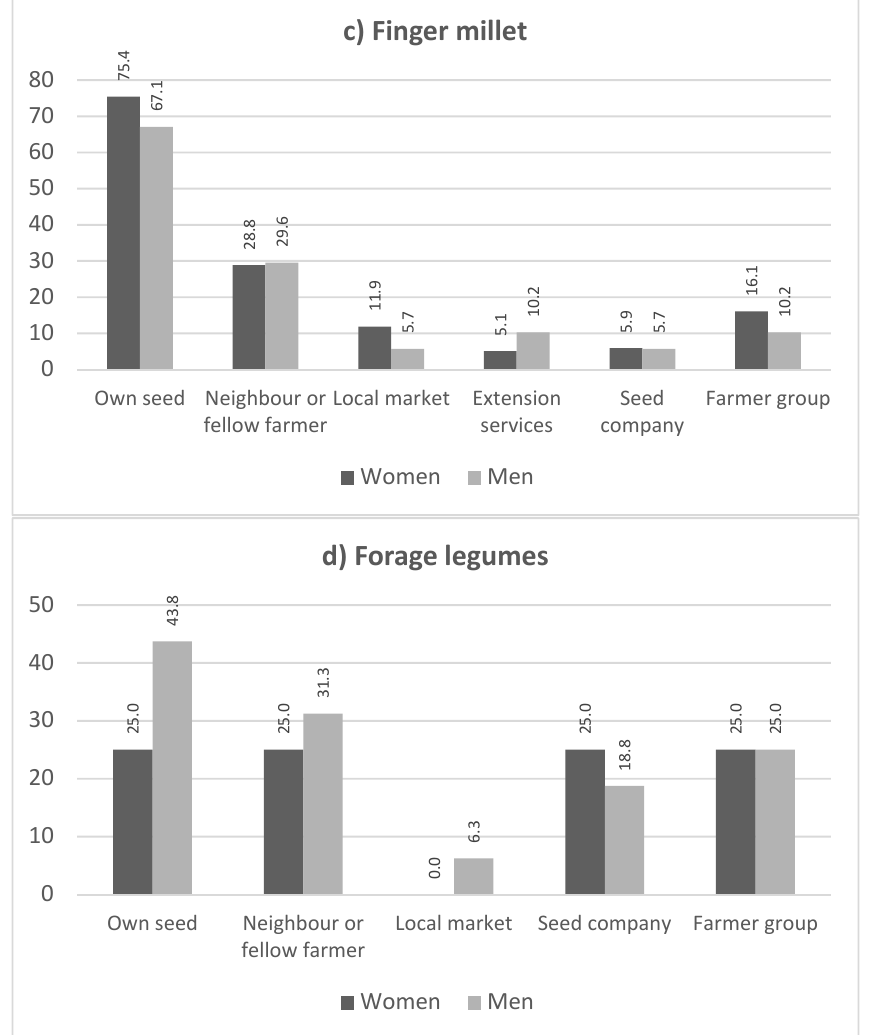
Figure A1. Seed sources by crop and sex (% of respondents) for ( a ) beans, ( b ) sorghum, ( c ) finger millet and ( d ) forage legumes. Chi square tests did not show any significant association between a specific seed source and respondent sex except for sorghum-extension services (** p < Table A3. Seed sources by crop, sex and country (% of farmers). Crop Country Seed Source All